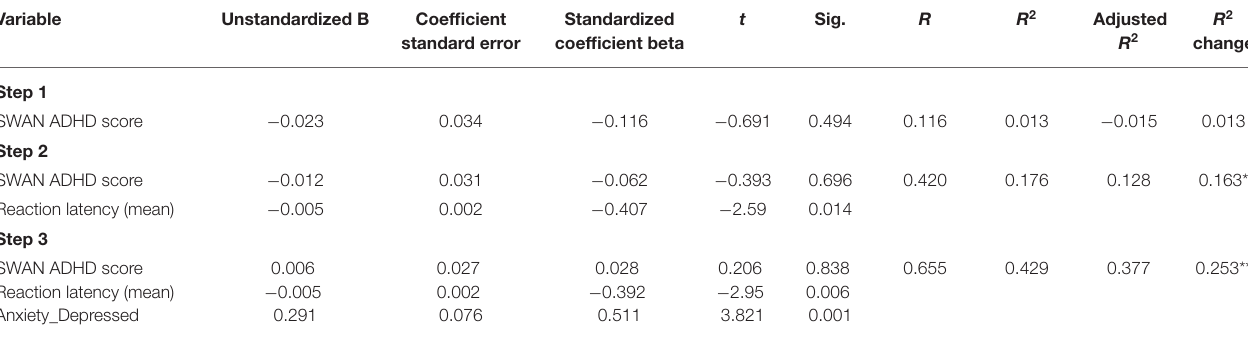
TABLE 13 | Regression model of the AST reaction latency and the CBCL Anxiety/Depression subscale scores as the predictors of the CBCL social problem subscale score in the SCT group.